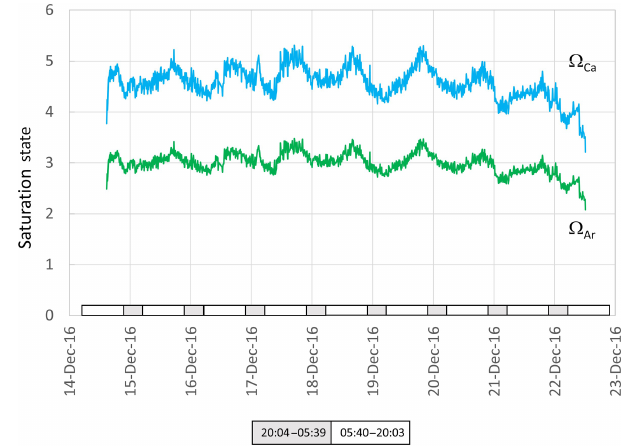
Figure 7. Aragonite (green) and calcite (blue ) saturation values cal- culated from data presented in Fig. 5. Grey and white boxes indicate the time between sunset and